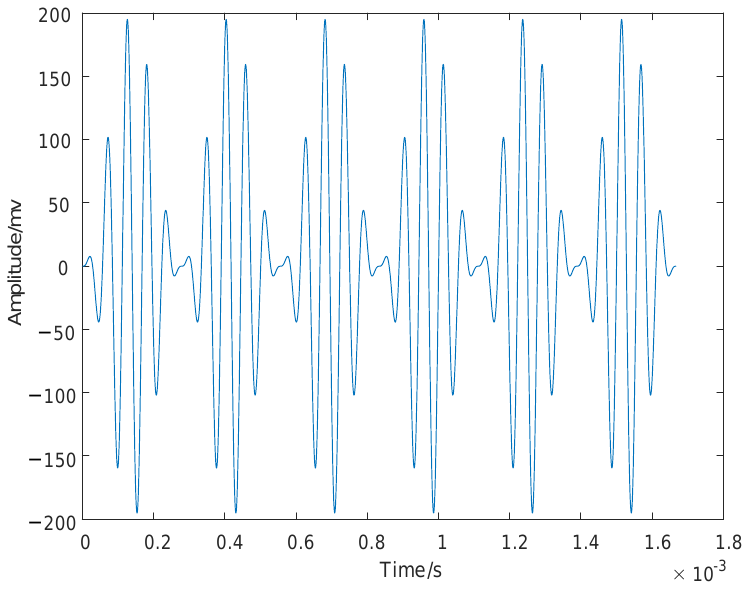
Figure 5. Excitation signal. The Lamb wave dictionary D is composed of moving the effective part of the excitation signal along the time axis whose reference is zero time, each time moving for 1.2 10 seconds, for a total of 2000 times, and the size of the Lamb wave dictionary is 2000 × 2000. Based on the Lamb wave dictionary, a fast block sparse Bayesian learning algorithm is used to sparsely represent the Lamb wave signal. Figure 6 shows the reference signals of channels 2–8 and their sparse representation signals. Figure 7 shows the fatigue stretching cycle times and the damage scatter signal and its sparse representation signal of channels 2–8 at 90,000 times.